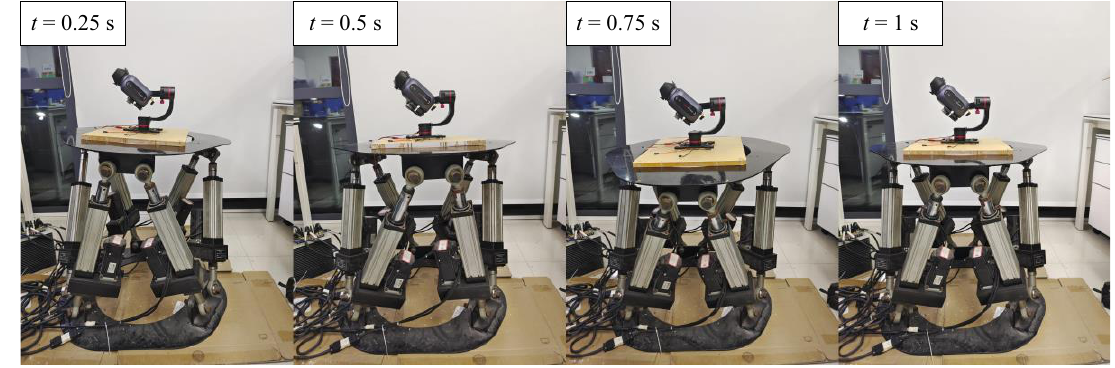
Figure 8. Experimental platform for mechanical stabilization at different timestamps.